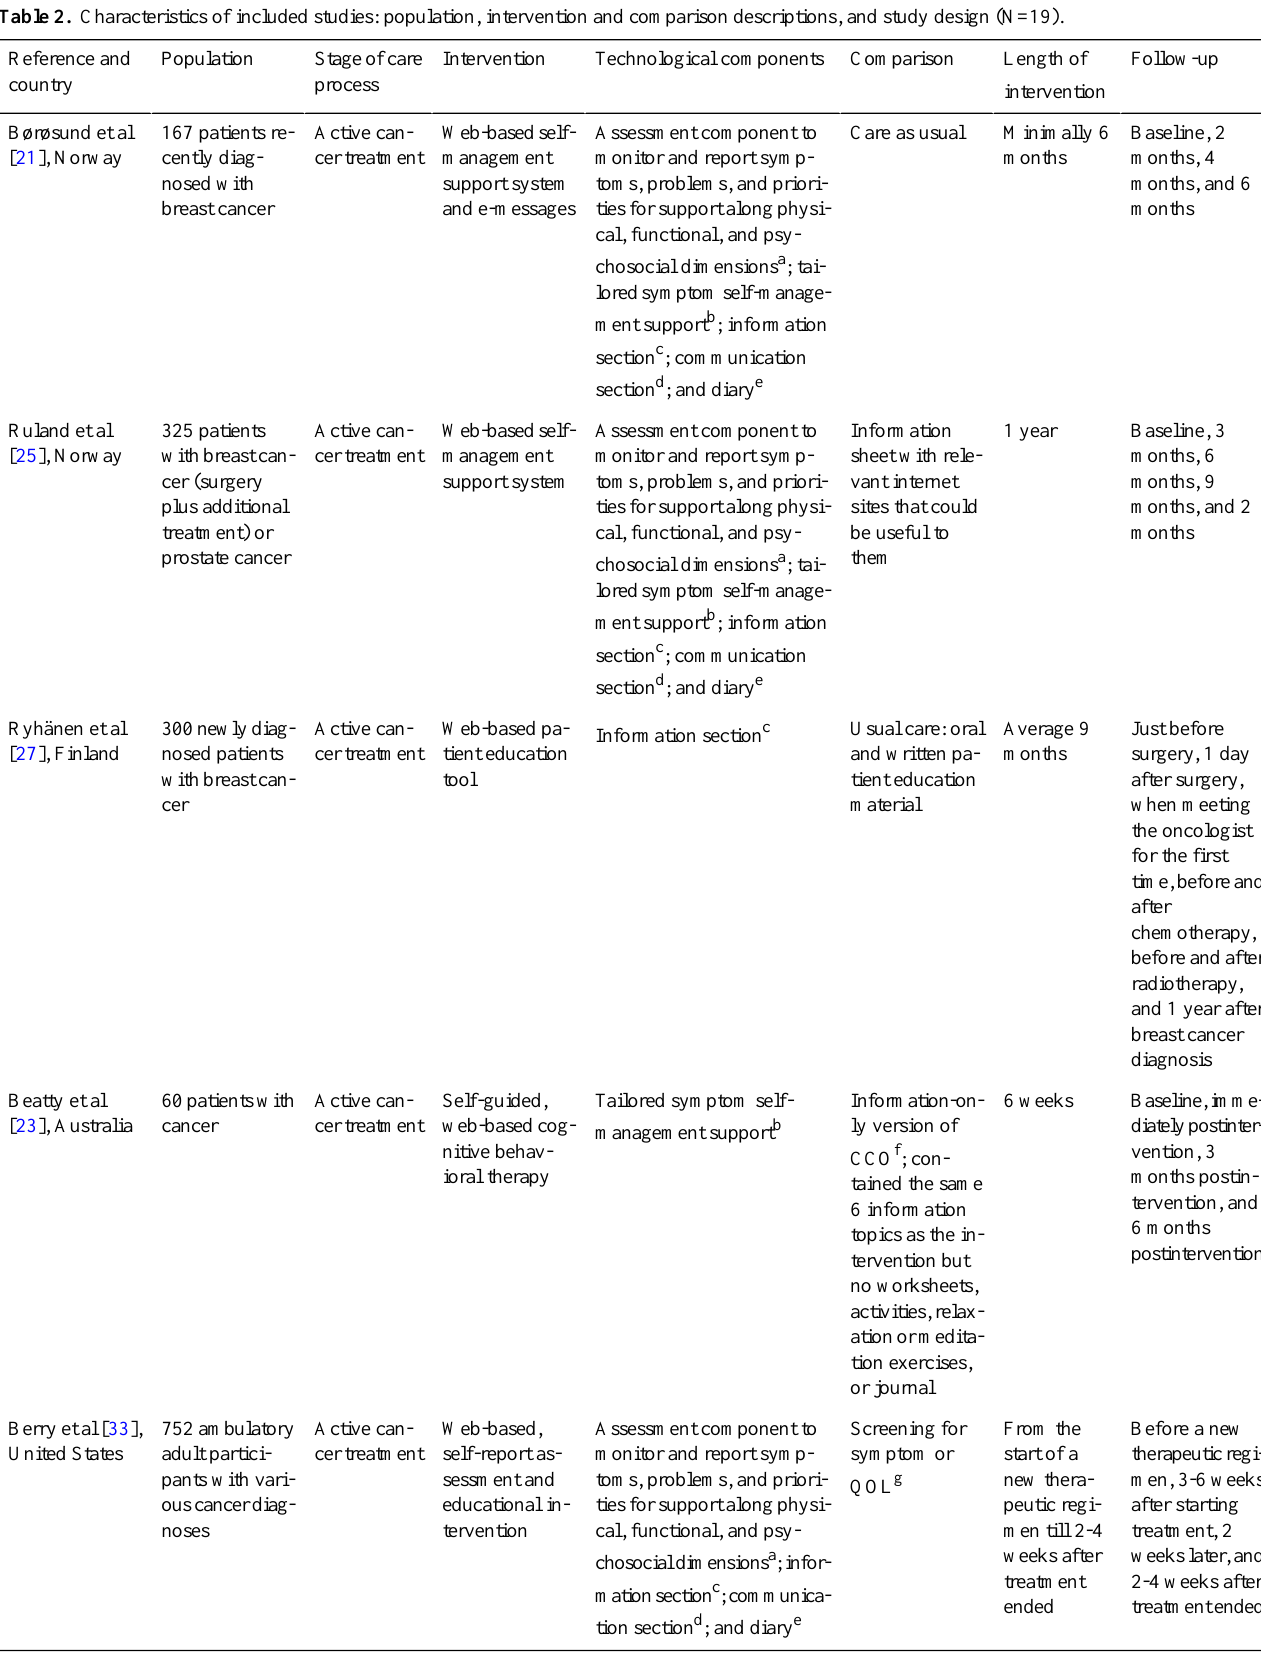
Table 2. Characteristics of included studies: population, intervention and comparison descriptions, and study design